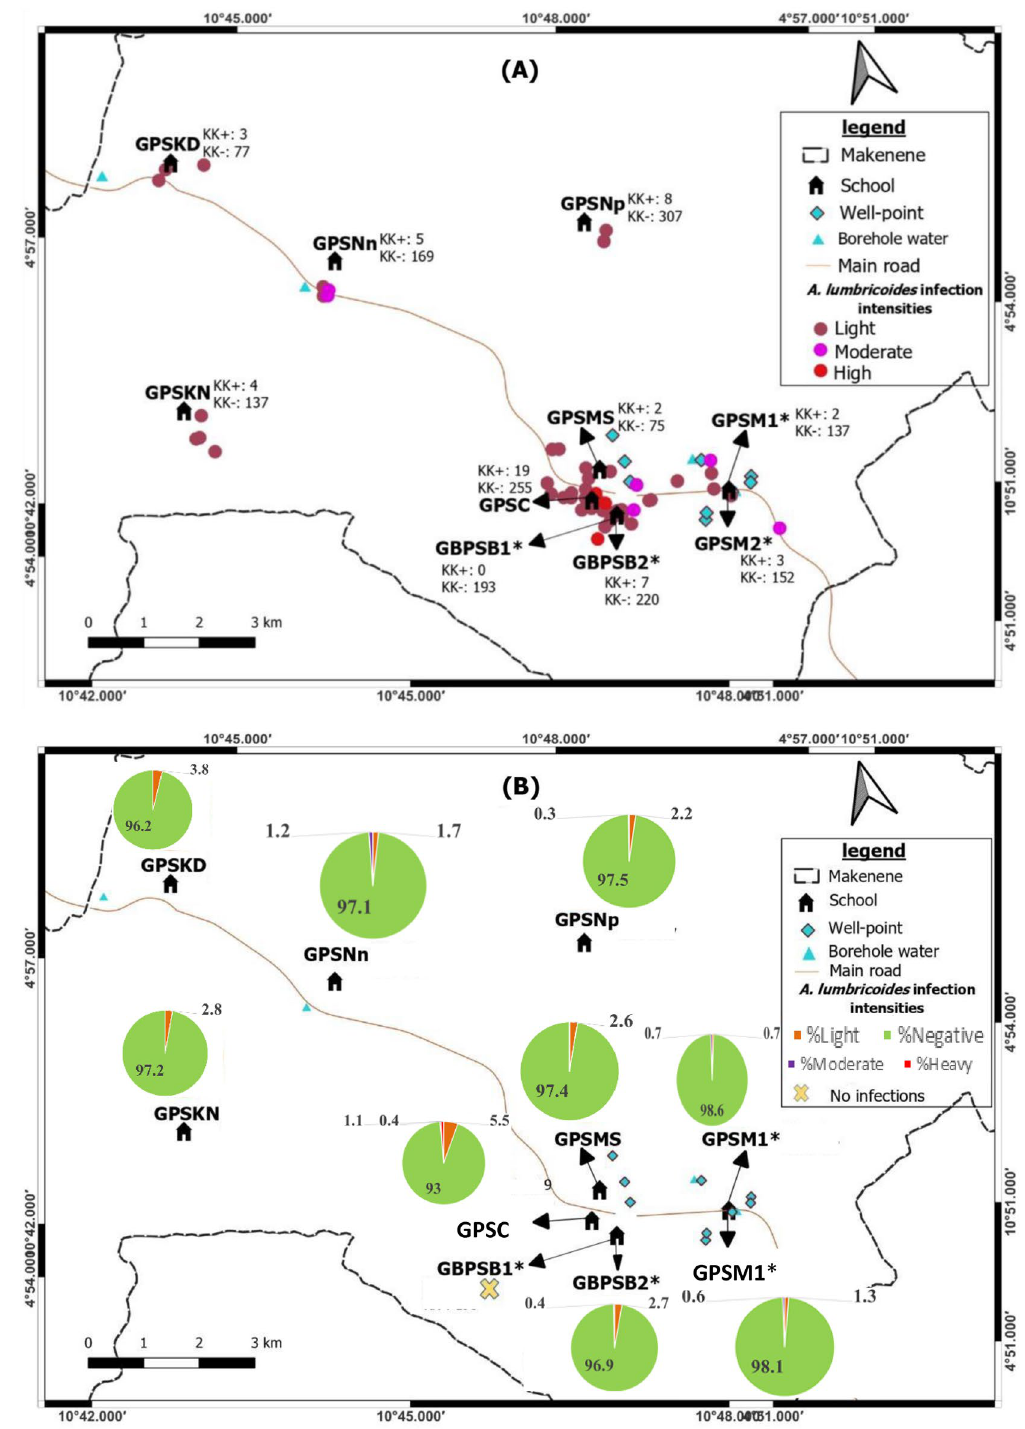
Figure 3. Map showing spatial distribution of Ascaris lumbricoides infections ( A ) and its infection intensities ( B ) according to schools (*both schools are hosted on the same building). GBPSB1: Government Bilingual Primary School of Baloua Group 1; GBPSB2: Government Bilingual Primary School of Baloua Group 2; GPSM1: Government Primary School of Makenene Group 1; GPSM2: Government Primary School of Makenene Group 2; GPSNn: Government Primary School of Nyokon; GPSKD: Government Primary School of Kinding Nde; GPSKN: Government Primary School of Kinding-Ndjabi; GPSMS: Government Primary School of Mock-Sud; GPSC: Government Primary School of Carrière; GPSNp: Government Primary School of